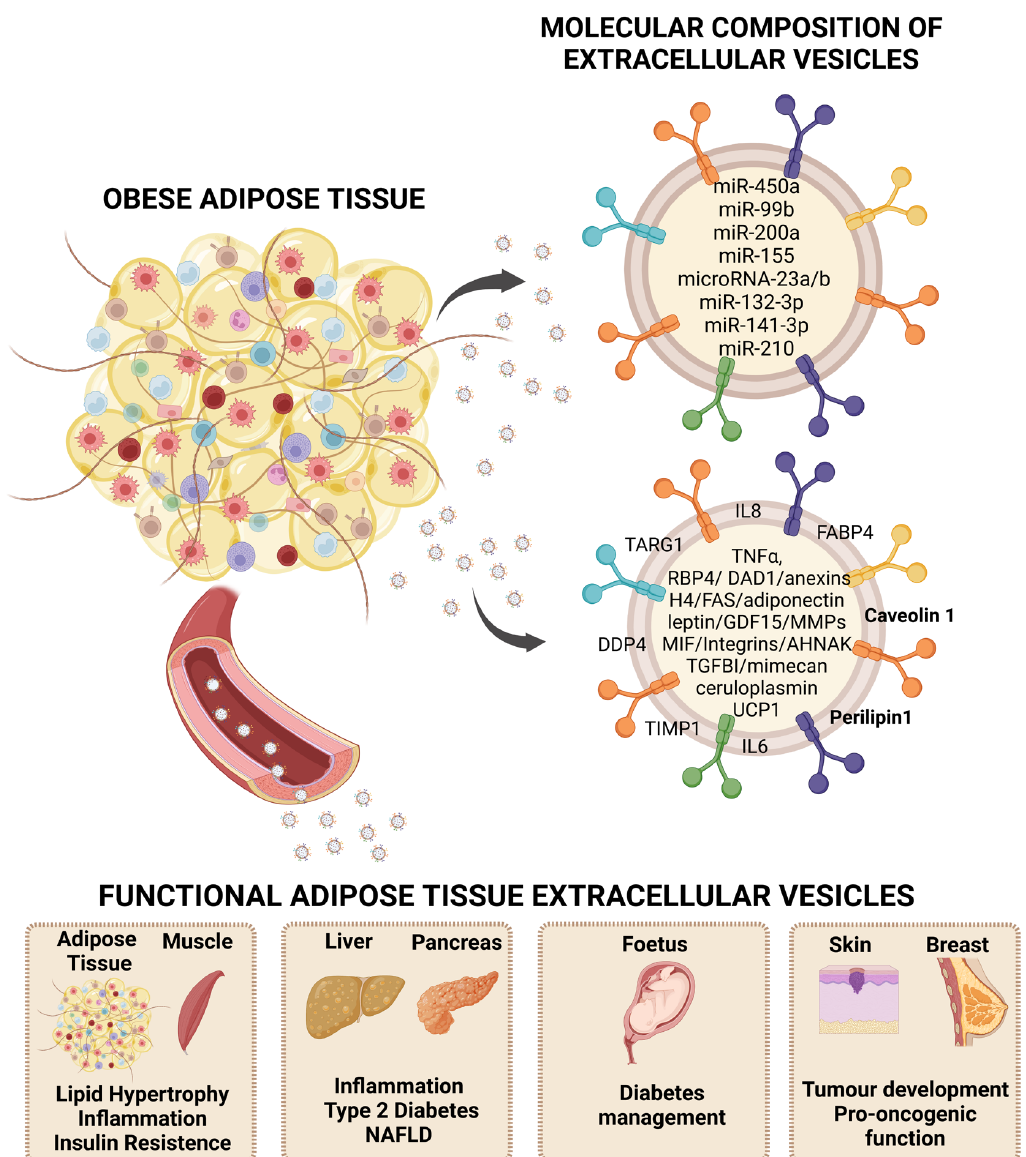
Figure 1. Extracellular vesicles (EVs) as carriers of adipokines and their role in obesity. Adipose tissue secretion of EVs as an alternative way of communication at the paracrine and endocrine levels that reflects characteristics of the metabolic status, thus, representing a rich source of disease biomarkers and exerting functional roles that participate in obesity-associated comorbidities. Representative bioactive cargo including microRNAs and protein content is shown. NAFLD: non-alcoholic fatty liver disease. Created by